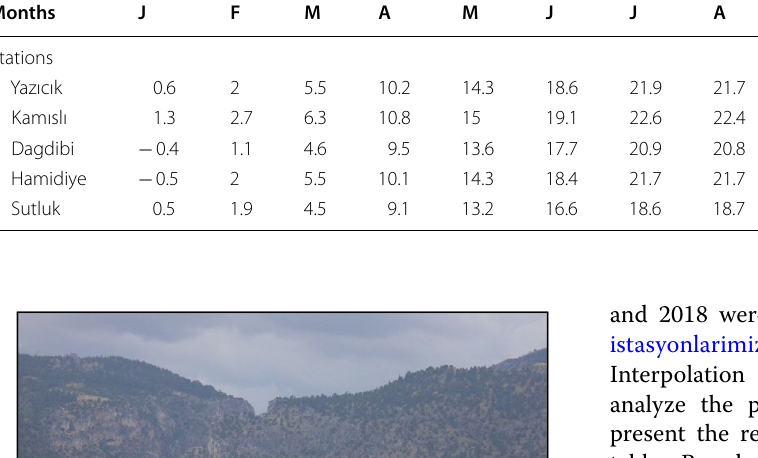
Table 1 Monthly average temperature values of the stations in the study area Months Average